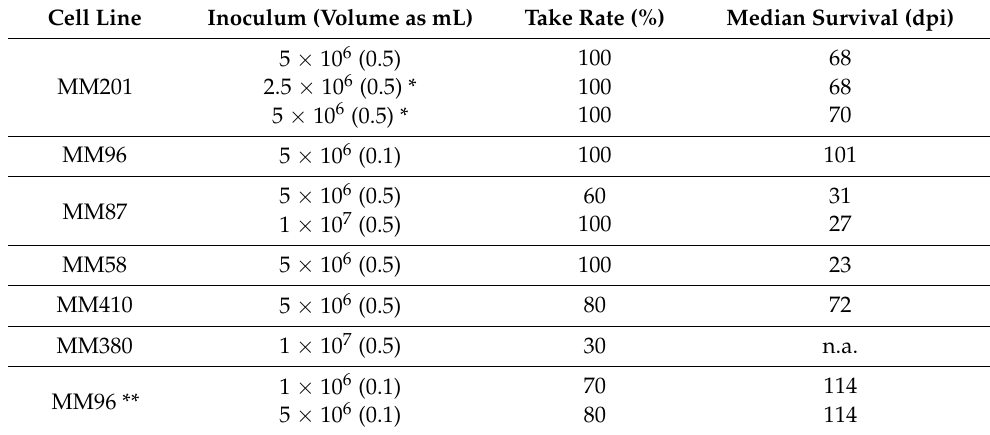
Table 1. Summary of tumorigenicity studies via i.p. and s.c. injection. Cell Line Inoculum (Volume as